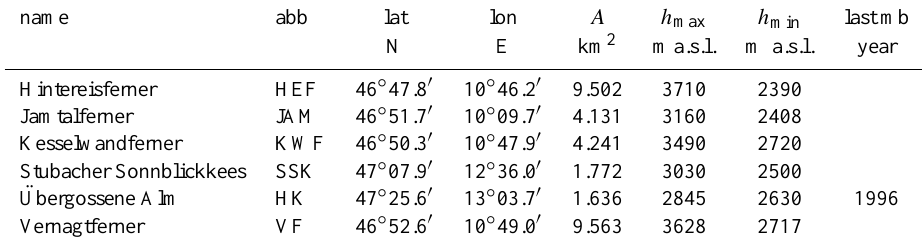
Table 1. Austrian glaciers chosen for the comparison the direct and the geodetic method. abb – abbreviation, lon – longitide, lat – latitude, A – area, h max maximum elevation in 1969 h min minimum elevation 1969, last mb – last year of mass balance if not ongoing.